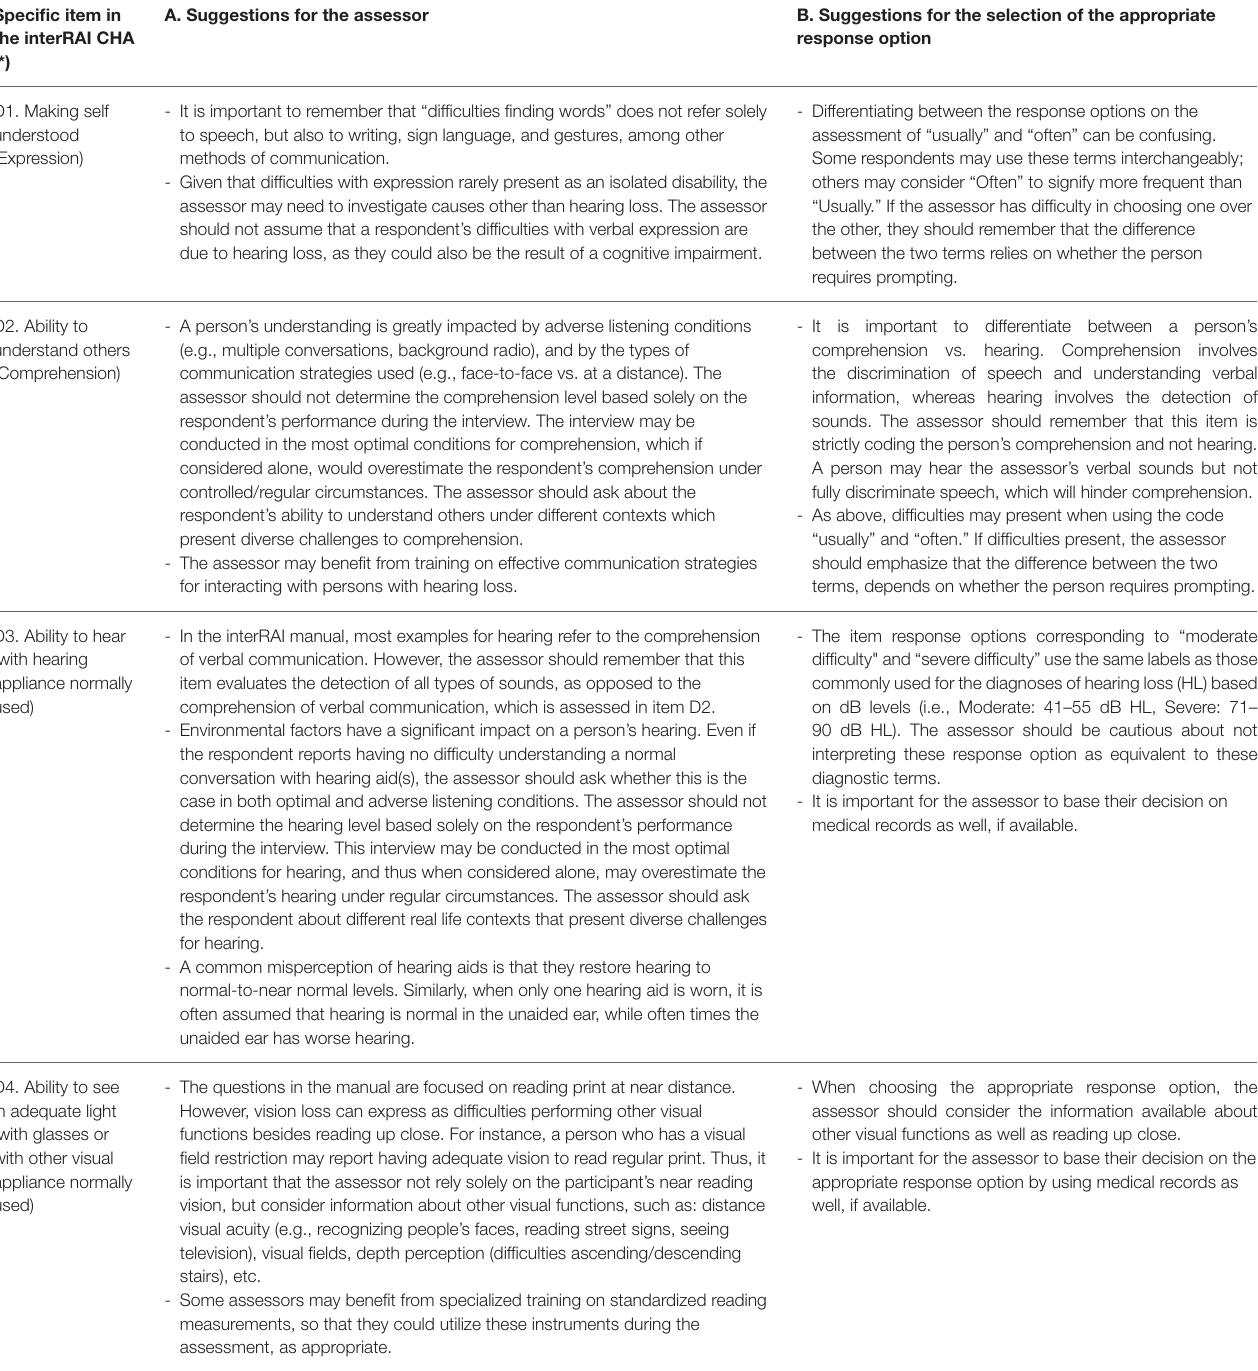
TABLE 2 | Supplemental guidelines for completing interRAI CHA section D communication and vision. Specific item in the interRAI